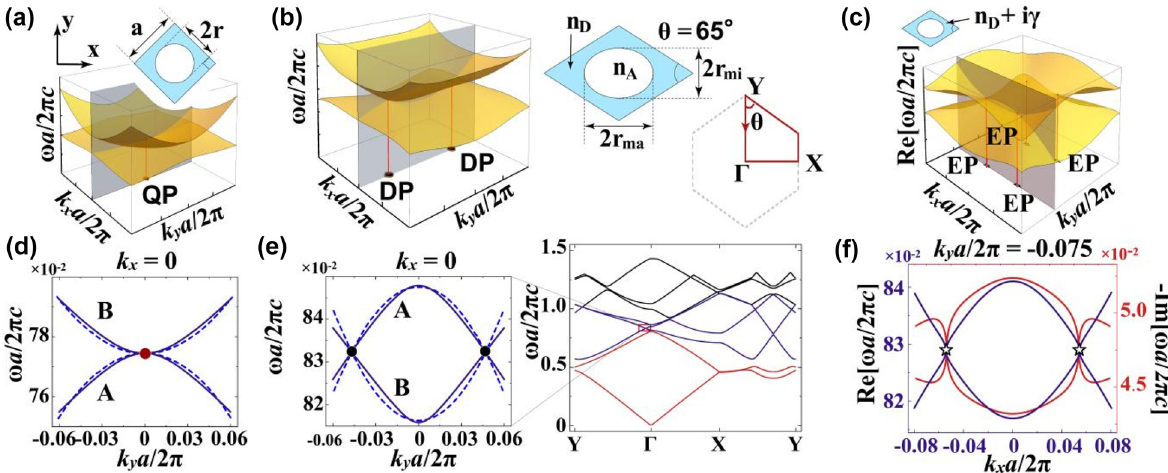
Figure 1: Stable EPs in the 2D reciprocal photonic crystals. = 1) in dielectric ( n = 1.46). Shown in the top is the unit cell with the (a) Band structure near the Γ point for a square lattice of air holes ( n A D = 0 direction [the gray surface in (a)]. The filled red circles lattice constant a and the hole radius r labeled herein. (d) The bands along the k x in (a) and (d) highlight the QP at the Γ point. (b) Band structure near the Γ point for an orthorhombic lattice. The rhombic unit cell depicted in ( r ). (e) The full the right panel is characterized by the lattice constant a , the angle 𝜃 , and the major (minor) axis of the elliptical hole r ma mi band structure along the Y − Γ − X − Y direction is shown in the right-hand side, and the bands forming the DPs are shown in an enlarged view on the left-hand side. The filled black circles in the left panel of (b) and (e) denote the DPs in the Γ − Y direction. The A and B in (d) and (e) indicate the band symmetry. (c) The Re( 𝜔 ) surface near the Γ point for the orthorhombic lattice with an additional loss term in the + i γ . (f) The values of Re( 𝜔 ) [Im( 𝜔 )] along the gray surface in (c) are shown by the blue [red] lines. The open black stars in (c) dielectric as n D and (f) label the EPs spawned from the DP. The bands in (a), (b), and (c) and the dashed line in (d) and (e) are from the model Hamiltonian, while the solid line in (d), (e), and (f) are calculated by FEM for the Ez polarization. The parameters used are a = 1365 nm, r = 520 nm, 𝜃 = 65 ◦ , r = 1.19 r , and r = 0.76 r . The non-Hermitian strength in (c) and (f) is 𝛾 = ma mi